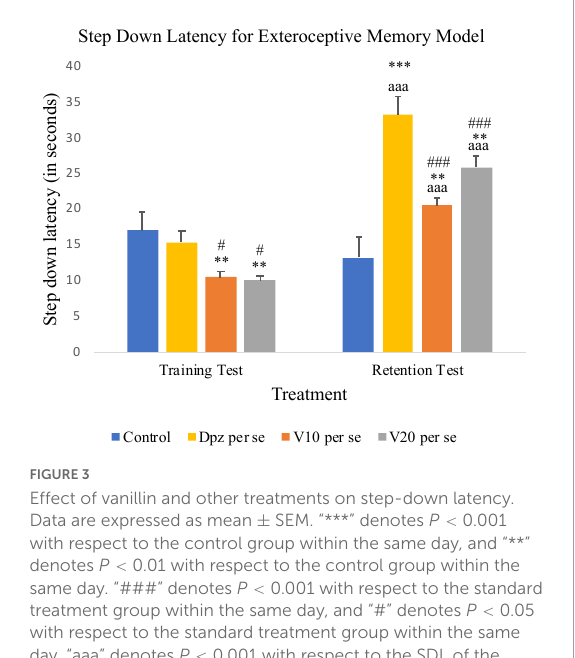
FIGURE3 Effect of vanillin and other treatments on step-down latency. Data are expressed as mean ± SEM. “***” denotes P < 0.001 with respect to the control group within the same day, and “**” denotes P < 0.01 with respect to the control group within the same day. “###” denotes P < 0.001 with respect to the standard treatment group within the same day, and “#” denotes P < 0.05 with respect to the standard treatment group within the same day. “aaa” denotes P < 0.001 with respect to the SDL of the same group on the 10th day of the treatment.